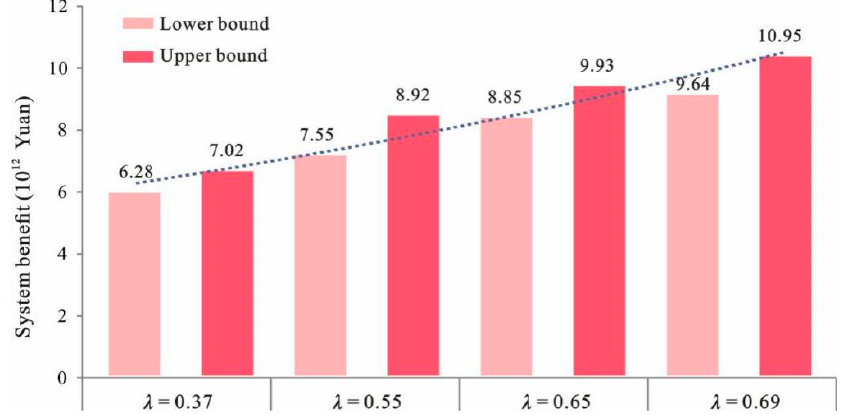
Figure 7. Relationship between λ and system